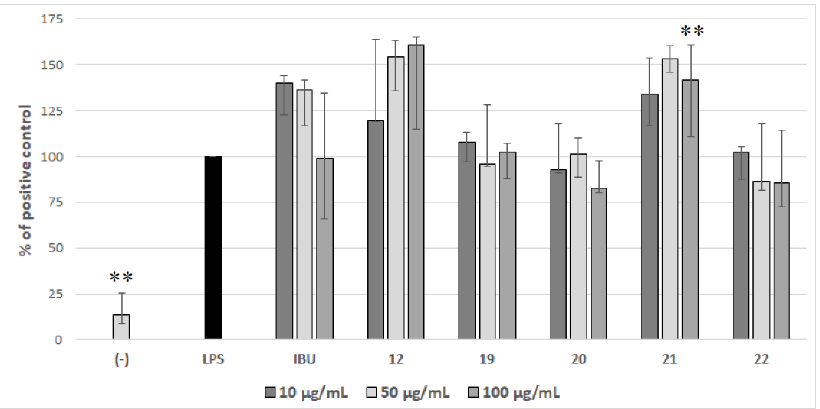
Figure 3. The effect of compounds 12 , 19 – 22 and IBU on the LPS-induced production of IL-6 in PBMC cultures (the results are shown as percentage of positive control (LPS alone), with values expressed as medians from five independent experiments and confidence intervals); ** indicates a significant difference compared to positive control (LPS alone) at p < 0.01.